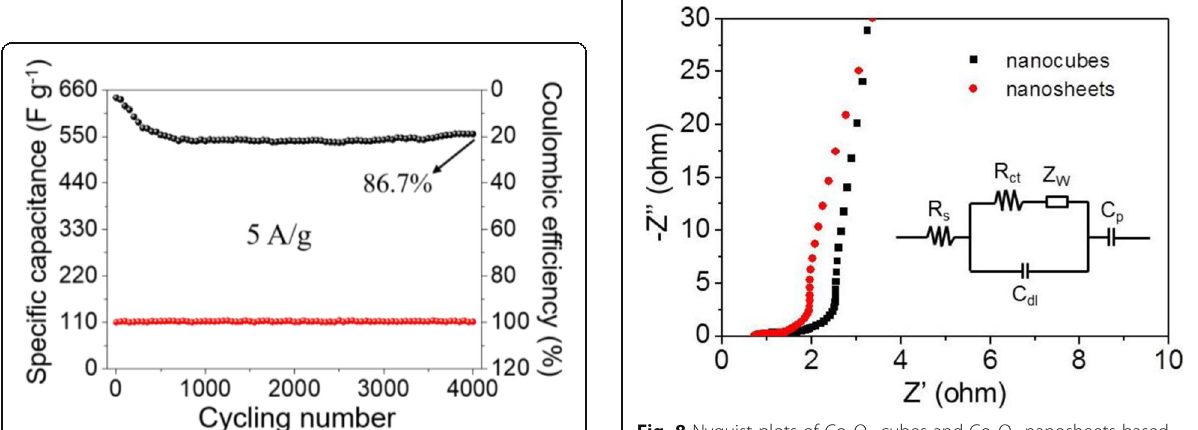
Fig. 8 Nyquist plots of Co 3 O 4 cubes and Co 3 O 4 nanosheets-based electrodes in 2 M KOH solution with the fitted equivalent circuit in the